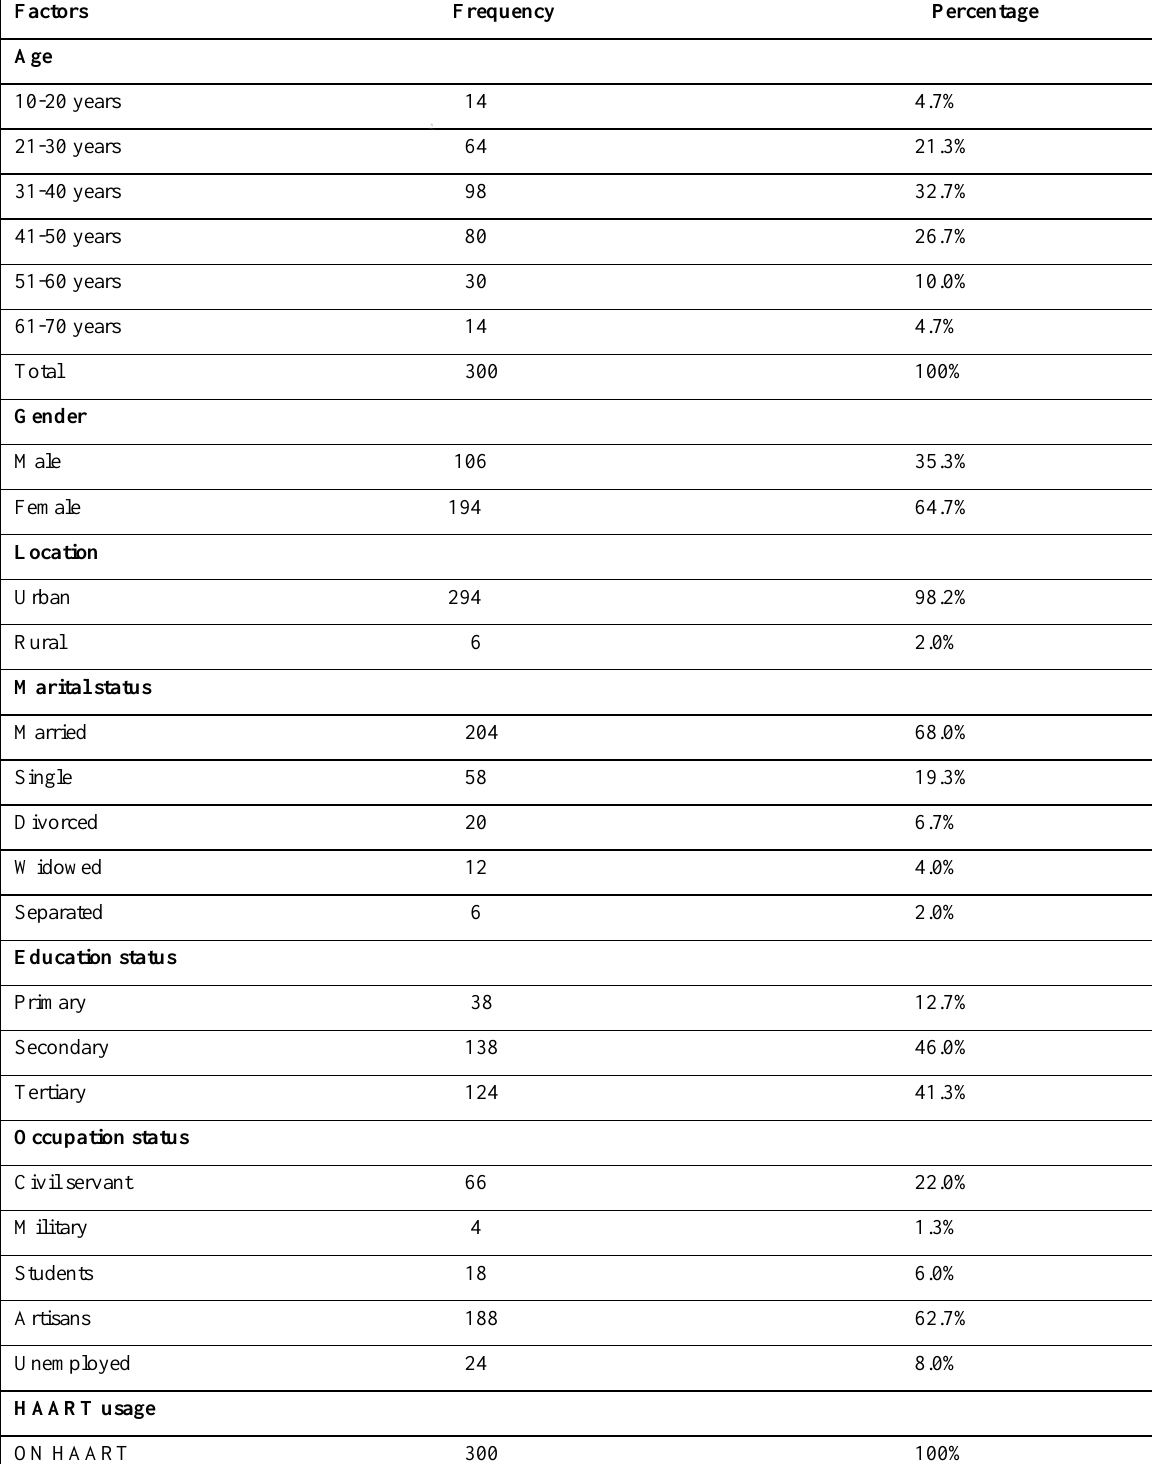
Table 1. Social-demographic characteristics of the